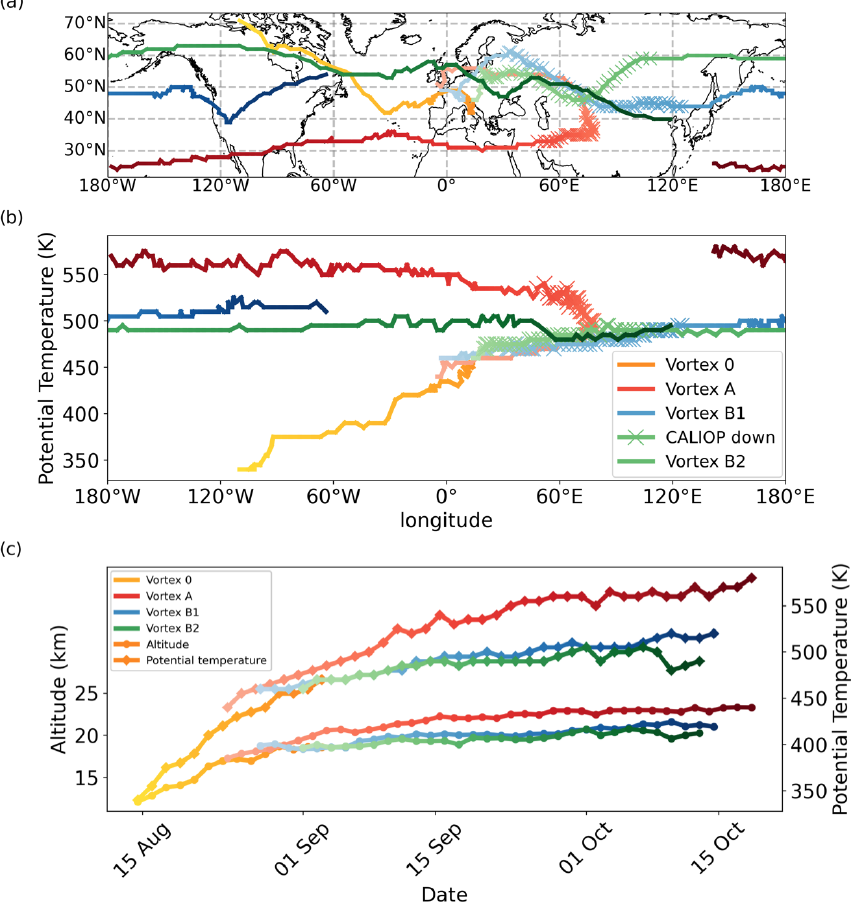
Figure 7. Trajectories of the vortices based on the low-ozone anomaly from the ERA5 analysis at a 6h sampling resolution. The colour gradient along each trajectory shows the time evolution of the vortices. We follow vortex O from 14 July 2017 until 31 August; it is then relabelled as vortex B2, and we follow its course until 11 October. Vortex A separates from vortex O on 22 August and is followed until 18 October. Vortex B1 separates from vortex O on 27 October and is followed until 14 October. Panel (c) shows the ascent in both altitude (left axis and lower set of curves) and potential temperature (right axis and upper set of curves). The crosses cover the part of each trajectory where CALIOP was not